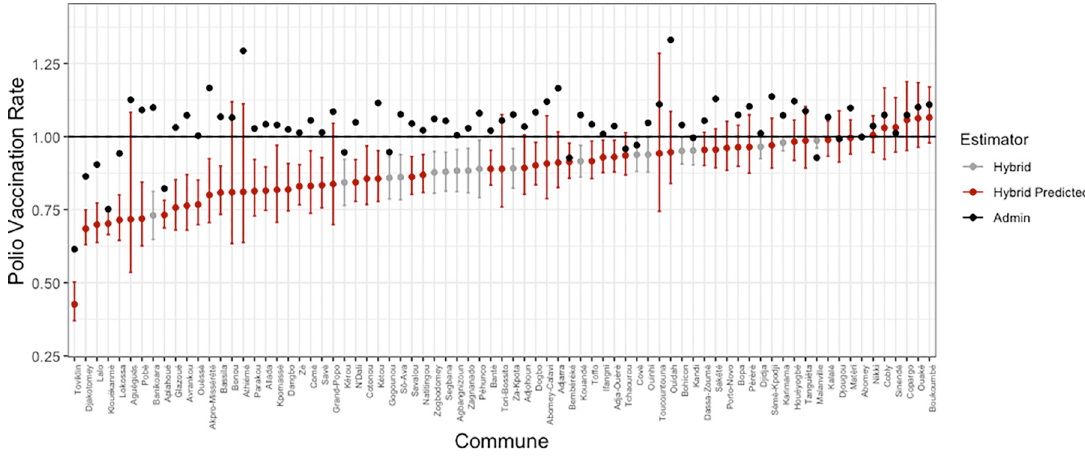
Fig 2. Frequentist estimates of polio vaccination rates by commune.